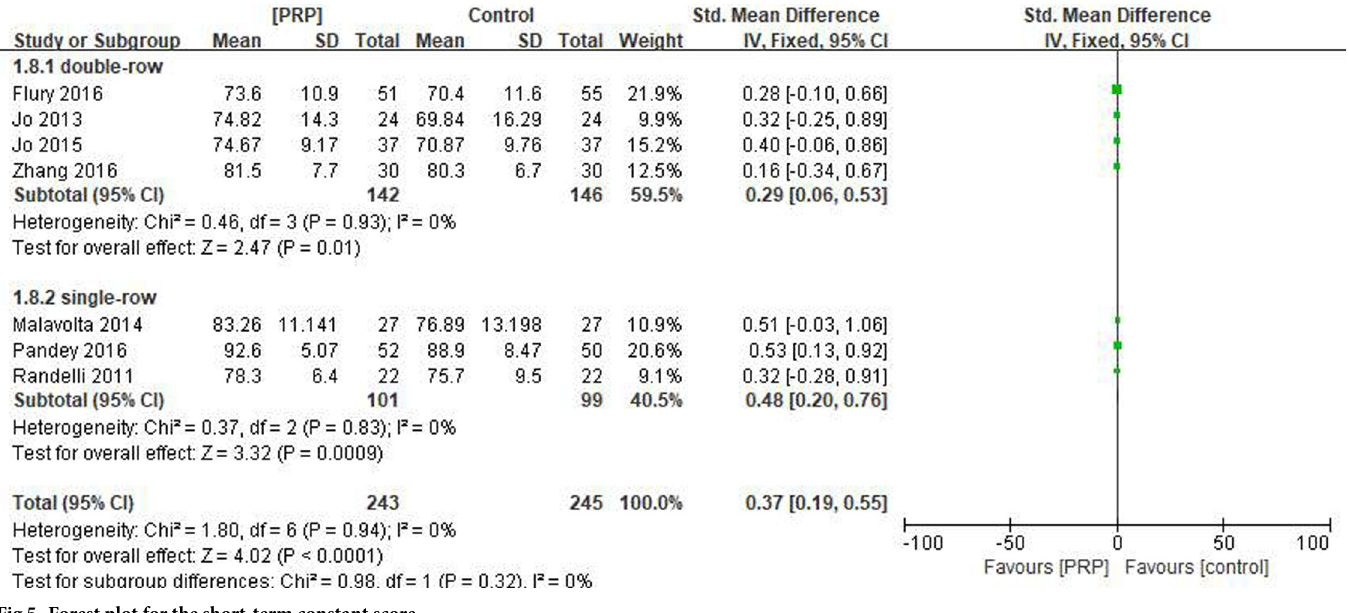
Fig 5. Forest plot for the short-term constant